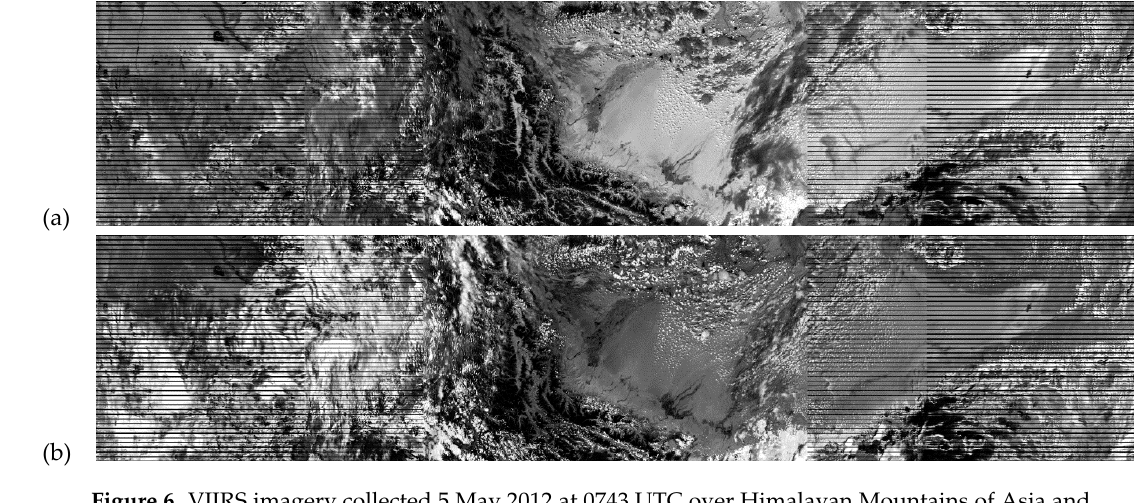
Figure 6. VIIRS imagery collected 5 May 2012 at 0743 UTC over Himalayan Mountains of Asia and shown in Figure 5. Figure 6 a shows the VIIRS M10 (1610 nm) imagery of scene while Figure 6 b shows this same scene in a brightness temperature difference image (BTD) of the M12 (3700 nm) minus M13 (4050 nm) or (M12-M13) VIIRS bands. Contrast between cirrus and water clouds versus land surfaces are more distinct in the BTD M12-M13 image than in the M10 image.